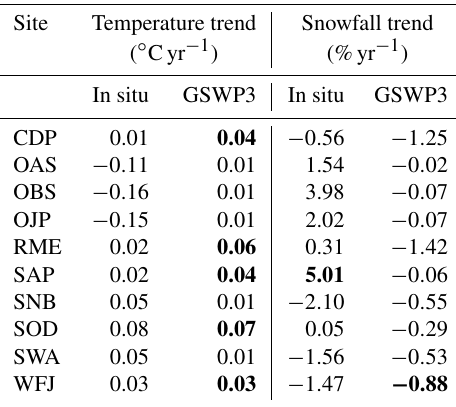
Table 5. Trends in annual mean temperatures and snowfall from in situ and GSWP3 data. Bold trends are statistically significant (Mann–Kendall p < 0 .